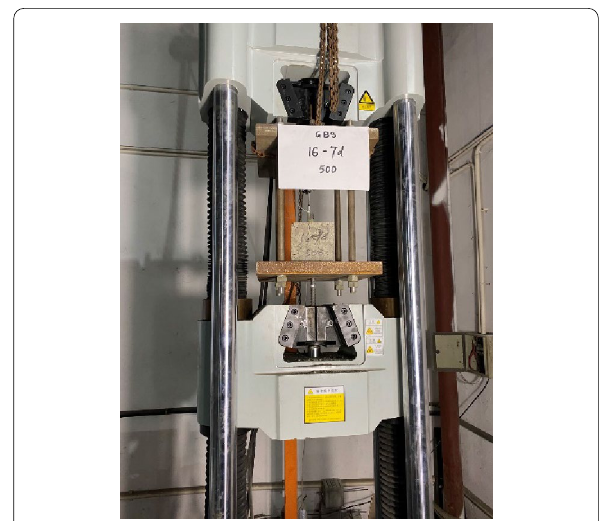
Fig. 5 The loading